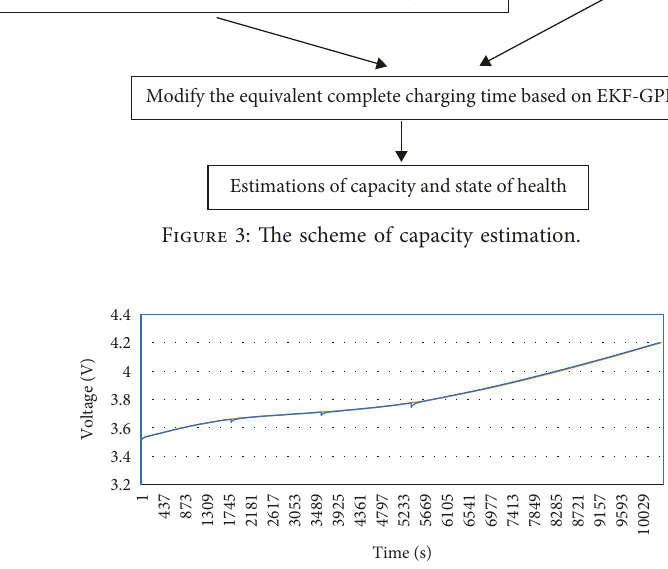
Figure 4: Comparison of the two complete charge